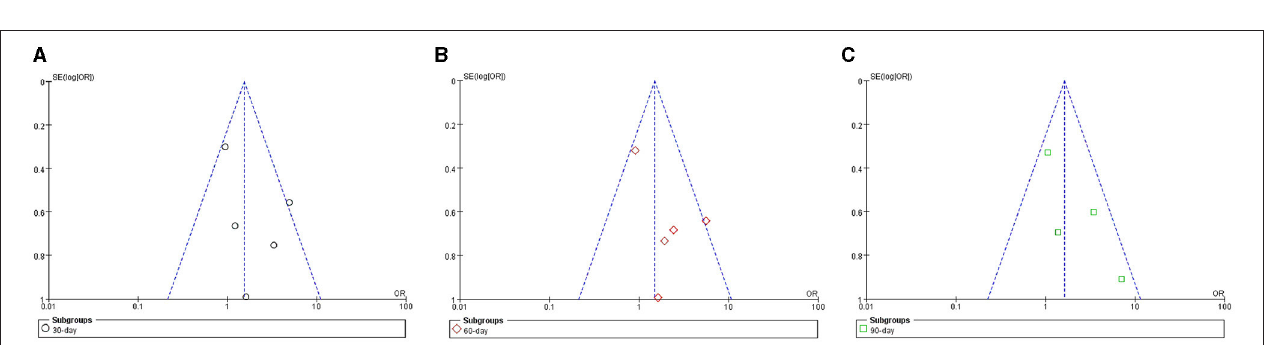
FIGURE 8 | Sensitivity analysis. Treated by G-CSF and controls. (A) 30-day; (B) 60-day; (C) 90-day.